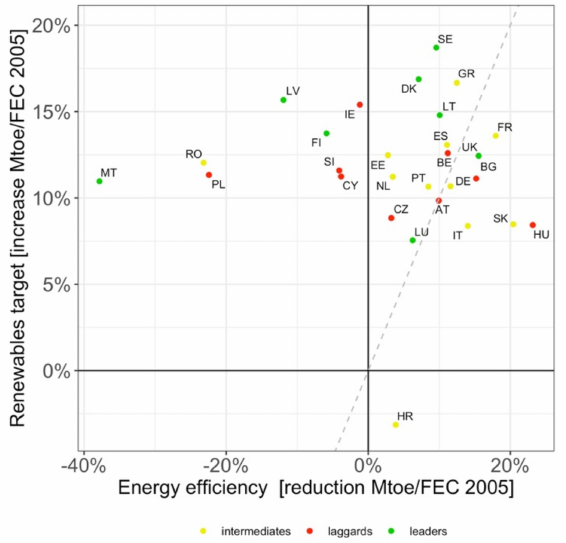
Figure 1. Ambition of 2020 renewables targets and ambition of 2020 energy e ffi ciency targets of all European Union Member States. Negative NEEAP numbers indicate a targeted absolute energy demand reduction. The dotted line indicates equal ambition for both policies; Member States to the right of the line have higher ambitions in energy e ffi ciency. Negative e ffi ciency targets indicate that countries plan to increase their FEC compared to 2005; negative renewables targets mean that countries plan to increase their energy supply faster than their renewable energy supply, based on expectation of economic